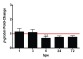

β-globin gene expression time-course in VHSV-exposed rainbow trout RBCs.RBCs were exposed to VHSV with a multiplicity of infection (MOI) of 1 at 14°C. Gene expression was quantified by RT-qPCR at time 0, 1, 3, 6, 24, 72 hours postexposure (hpe). Gene expression was normalized against eukaryotic 18S rRNA and relativized to control cells (non-exposed, time 0, red line) (fold-change). Data is displayed as mean ± SD (n = 3). Kruskal-Wallis Test with Dunn´s Multiple Comparison post-hoc test was performed among all conditions. Values denote pairwise significant differences with the value-indicated condition (
P-value < 0.05).